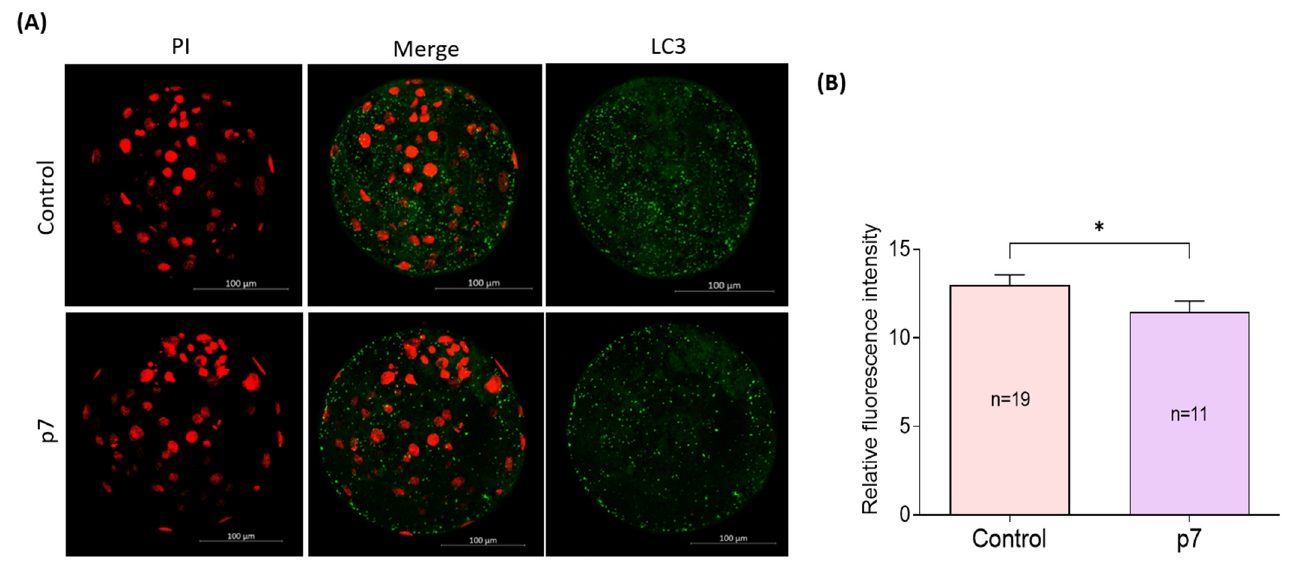
Figure 8. ( A ) Representative fluorescence images show the presence of LC-3 protein in blastocysts. ( B ) Fluorescence intensity of LC3 in blastocysts. The asterisks represent significantly different when compared to the control (*: p < 0.05). Scale bar = 100 μ m.